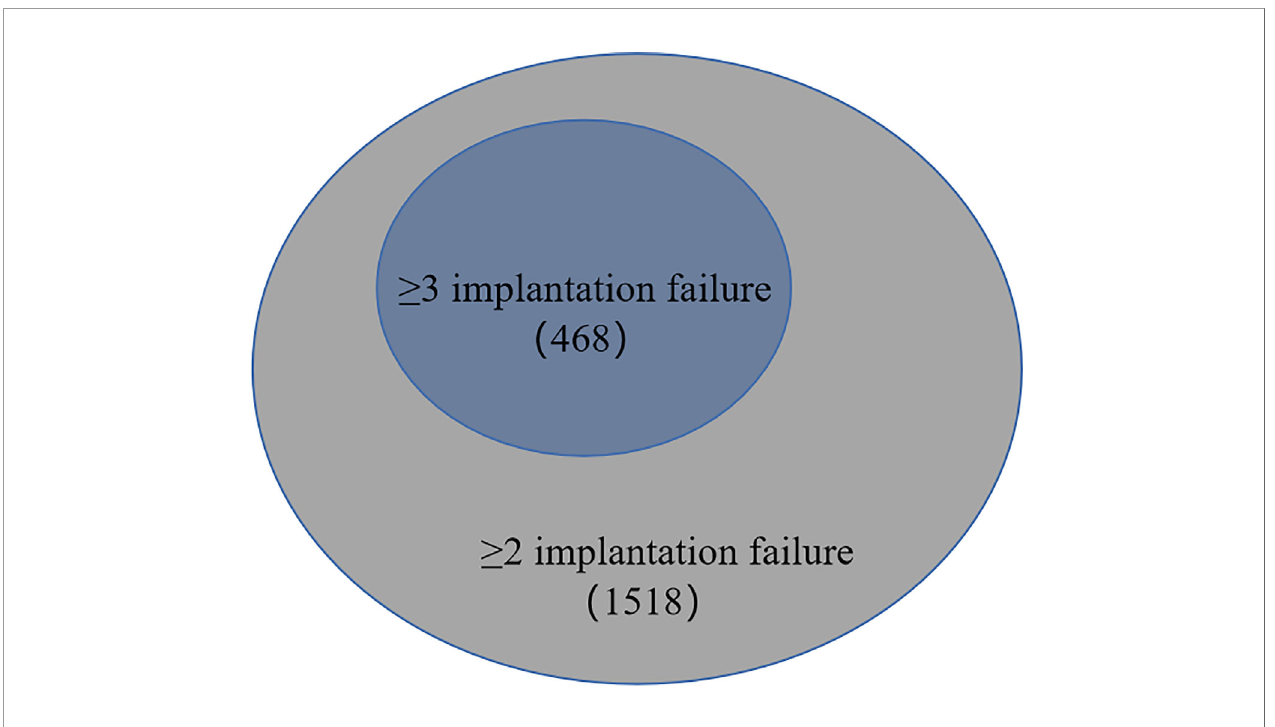
FIGURE 2 | The number of RIF patients with two different de fi nitions.